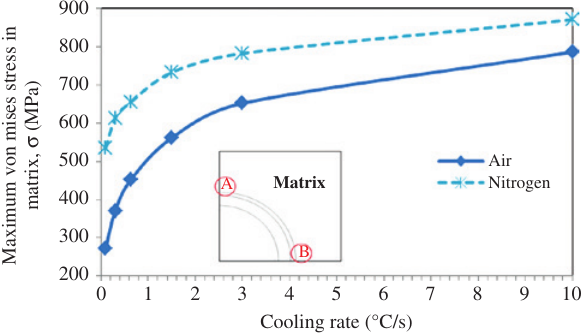
Figure 5: Variation of maximum von Mises equivalent residual stress in the matrix in air and nitrogen environments as a function of the cooling rate with FVF = 32%.